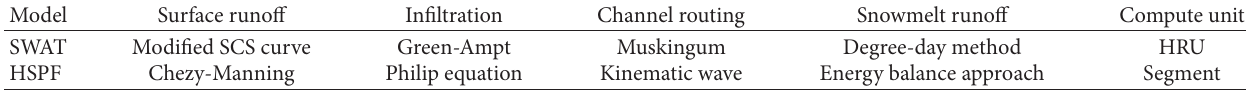
Table 1: Summary of the approaches adopted in SWAT and HSPF for hydrological process